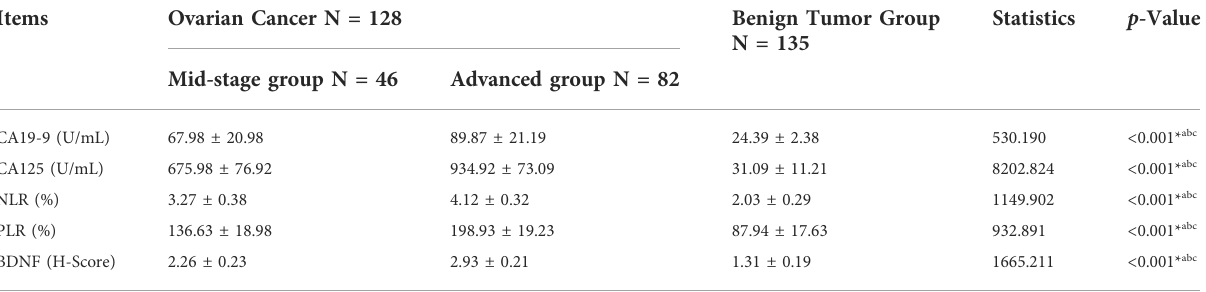
TABLE 2 | Comparison of the levels of CA19-9, CA125, NLR, PLR, and BDNF in each